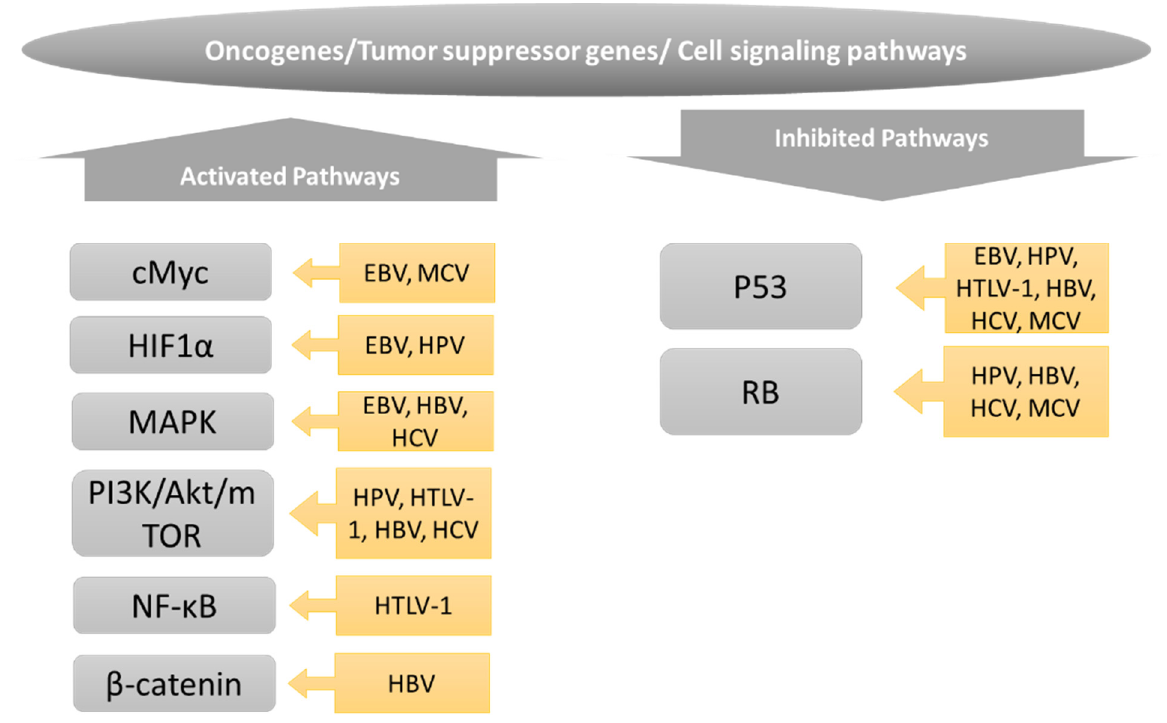
Figure 3. Oncogenes, tumor suppressors, and transcription factors implied in the metabolic alter- ations associated with oncogenic transformation and oncoviral infections . See text for